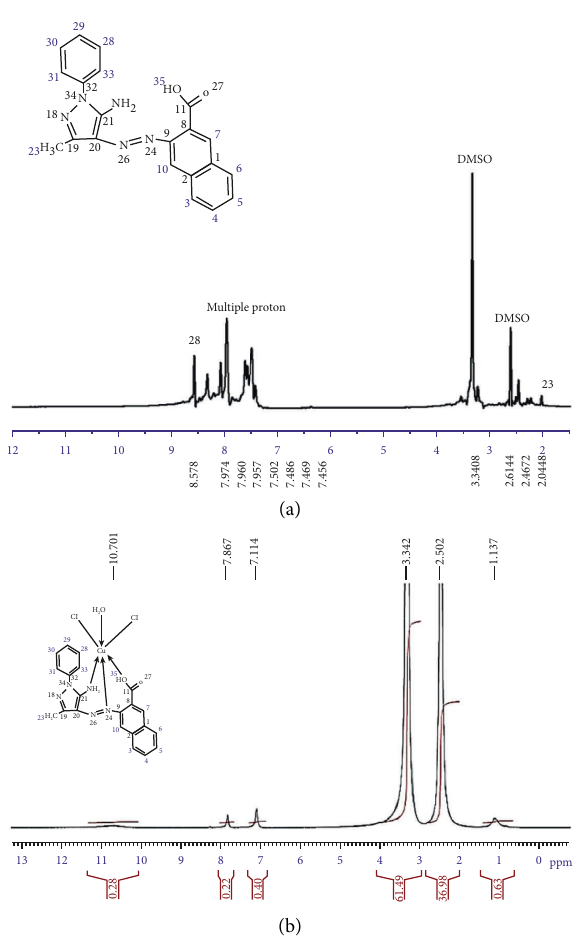
Figure 4:1H-NMR chemical shifts of compounds (ppm, 500MHz, DMSO-d6 solutions, room temperature) for (a) HL ligand and (b) Cu(II)L.